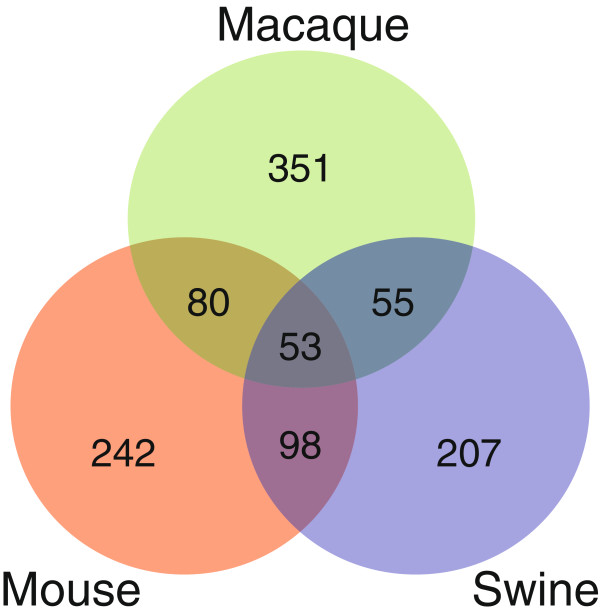
Comparison of significant host genes differentially regulated during CA04 infection in each species. Venn diagram showing the overlap between mouse (red), macaque (green) and swine (blue) DE gene sets.